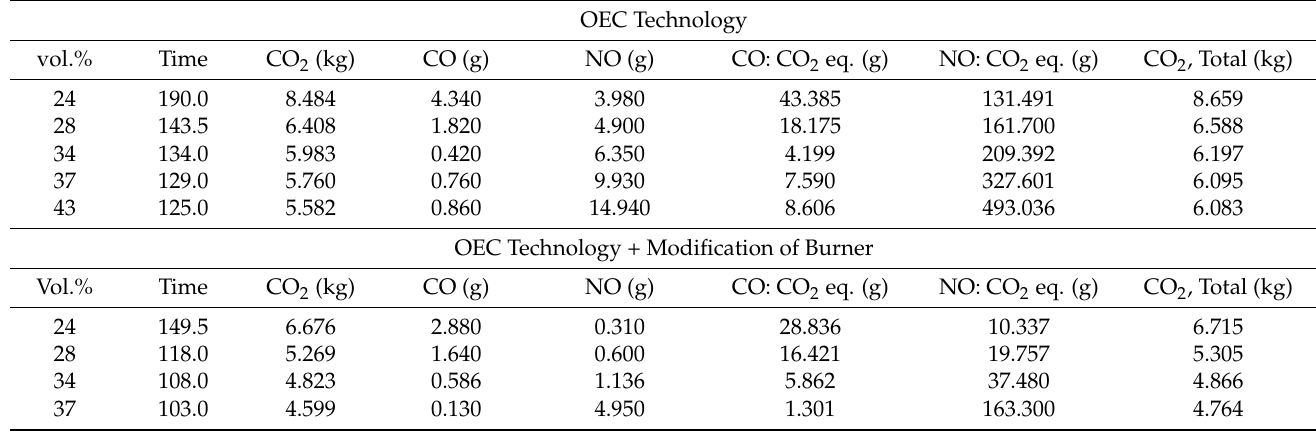
Table 5. Summary of emissions produced in the melting of charge material, depending on oxygen concentration in the oxidant used.